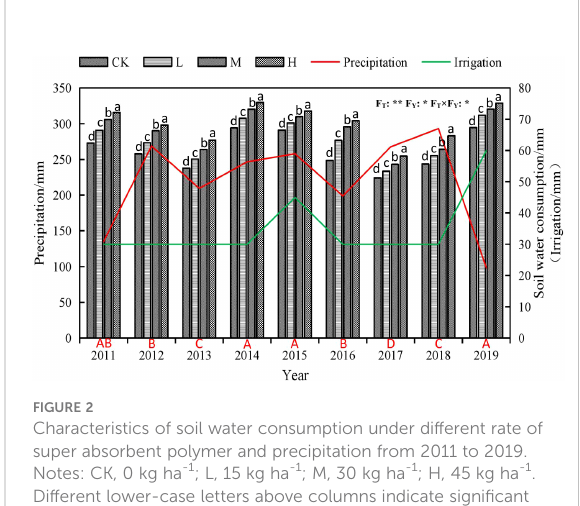
FIGURE 2 Characteristics of soil water consumption under different rate of super absorbent polymer and precipitation from 2011 to 2019. Notes: CK, 0 kg ha -1 ; L, 15 kg ha -1 ; M, 30 kg ha -1 ; H, 45 kg ha -1 . Different lower-case letters above columns indicate signi fi cant differences between four treatments in the same year by Scheffe ́ test ( P < 0.05). Different upper-case letters under columns indicate signi fi cant differences between mean value of four treatments in different years by Scheffe ́ test ( P < 0.05). F T , F Y and F T ×F Y mean F-values of treatments, years and their interactions in variance analysis respectively. “ * and ** ” indicate difference at the 0.05 and 0.01 levels, respectively.